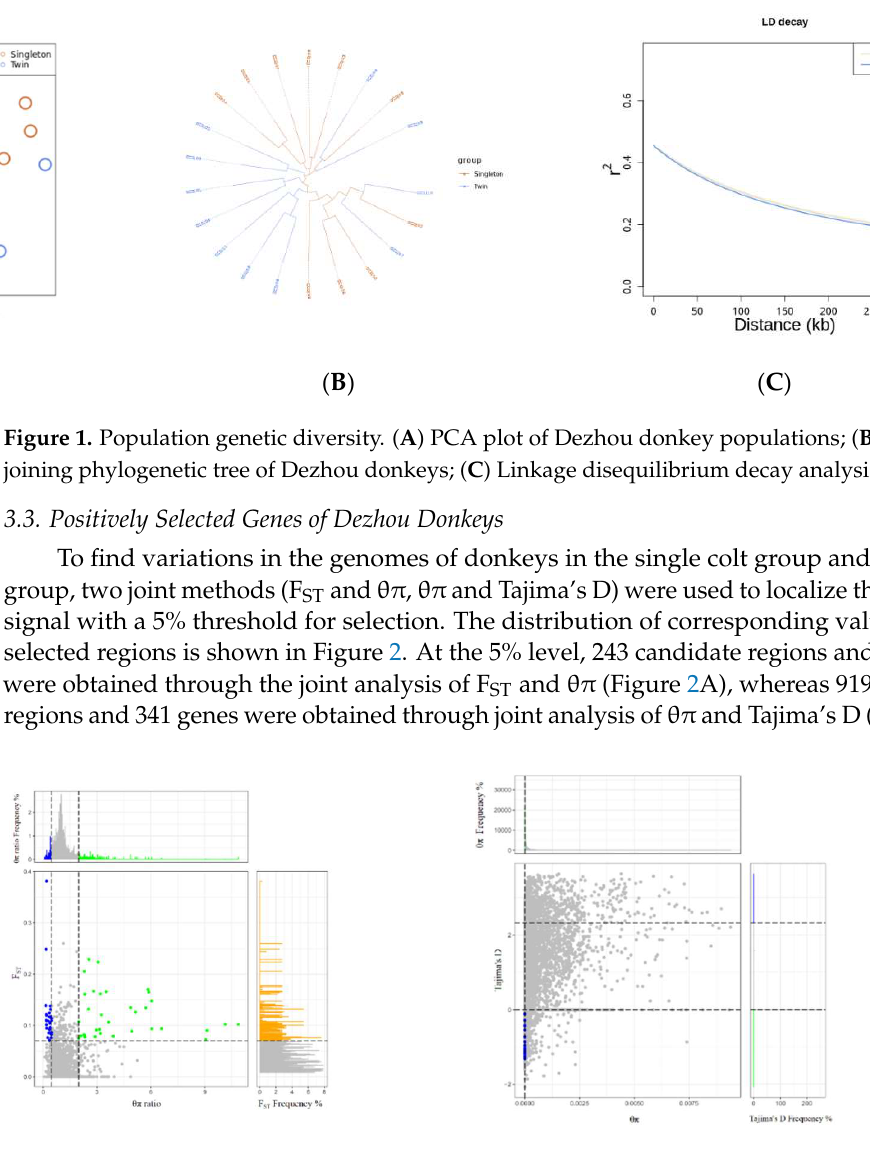
Figure 2. Intersection of the joint analysis used to identify selection regions. ( A ) Distribution of θπ ratios (θπ, single colt group /θπ, twin colt group) and F ST values, which are calculated in 100 kb